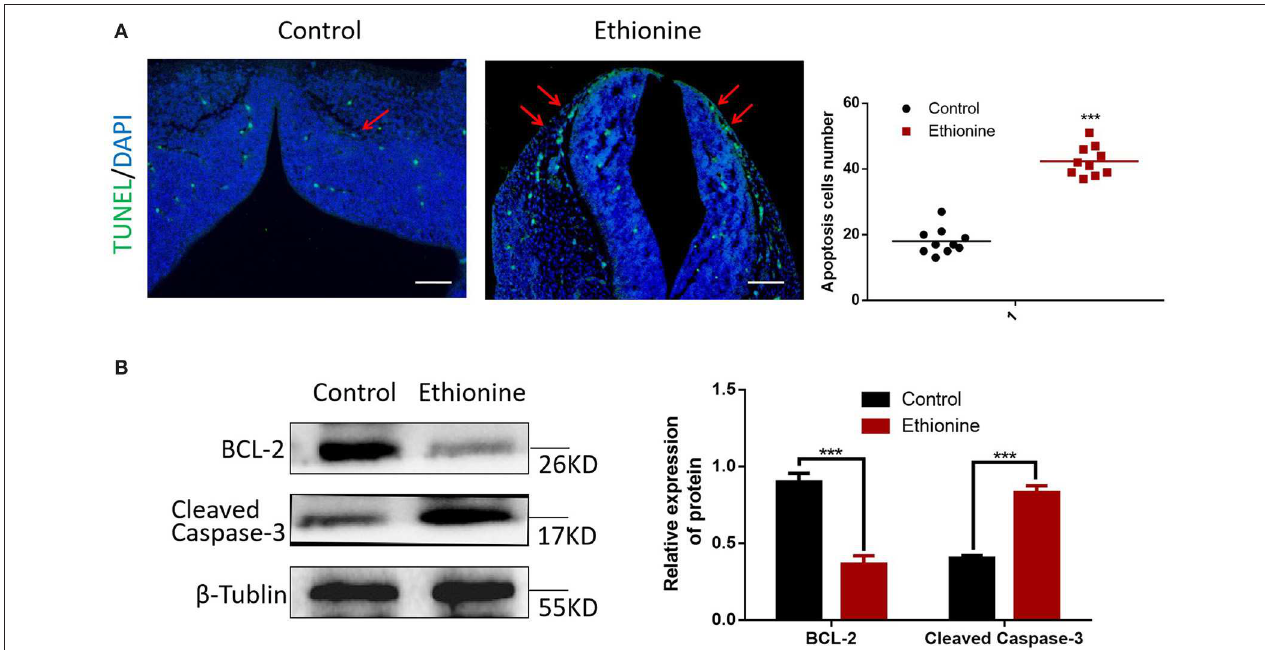
FIGURE 2 | Ethionine induced cell apoptosis in normal and NTD embryos. (A) Representative TUNEL assay images showing apoptotic cells (Green dots) in E13.5 embryos and quantification of TUNEL positive cells ( n = 3, *** P < 0.001 vs. control group). Cell nuclei were stained with DAPI (blue). Scale bars: 500 µ m. Data were analyzed with ImageJ Software. (B) BCL-2 and Cleaved Caspase-3 protein levels in control and ethionine groups were evaluated via Western blotting. β -Tublin levels were also evaluated to confirm equal loading ( n = 3). Each experiment was carried out in triplicates *** P < 0.001 vs. control